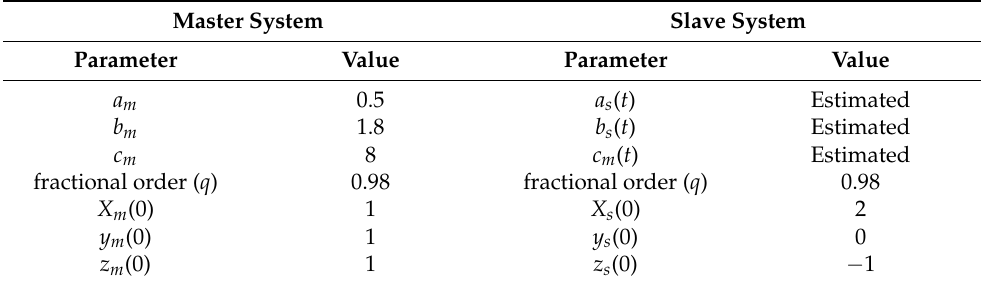
Table 1. Master and slave parameters